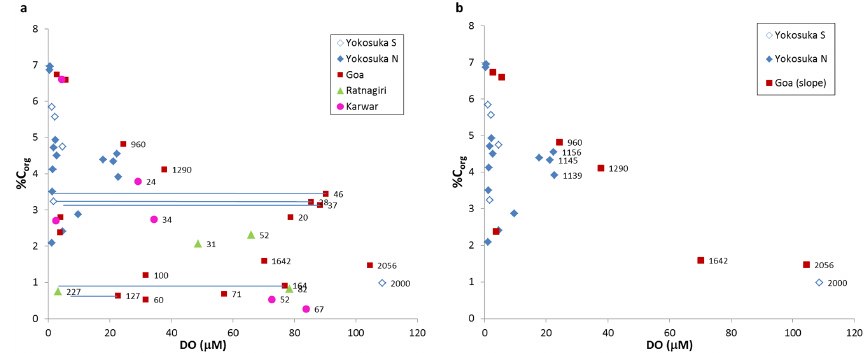
Figure 7. Plots of surface sediment organic C content (%C org ) against bottom-water dissolved oxygen concentration (DO, µM); (a) all sites, and (b) for slope sites (>200m) for the Goa and Yokosuka transects. DO concentrations were either measured directly from a submersible (Yokosuka transects) or in near-bottom bottle samples. All sediment samples and DO data for Goa, Ratnagiri and Karwar transect sites were collected during intermonsoon (normoxic) period. Horizontal lines for five Goa transect shelf sites indicate bottom-water DO values encountered during the monsoon season (shelf hypoxia). Data labels show station depths for shelf sites and slope sites near and below the lower OMZ boundary (> ∼